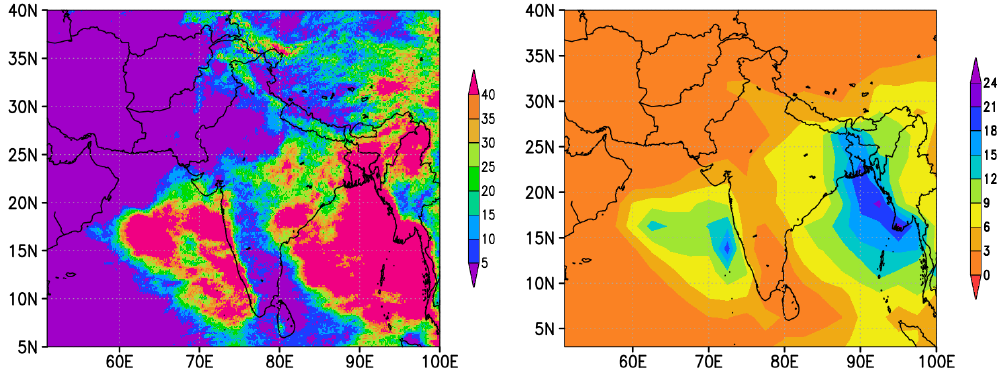
Figure 2. (a) Frequency of occurrence of convection per month derived from Meteosat-5 and (b) monthly mean precipitation (mmday − 1 ) from Global Precipitation Climatology Project (GPCP) for June